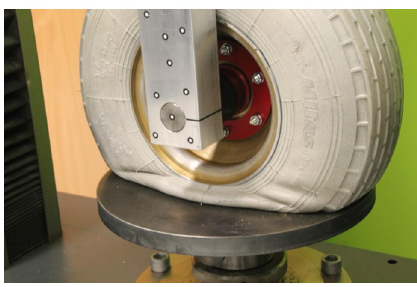
Figure 8. The deflection of the tyre with the value z 2 = 77.45 mm, which was adopted as the limit value of the safe deflection for the